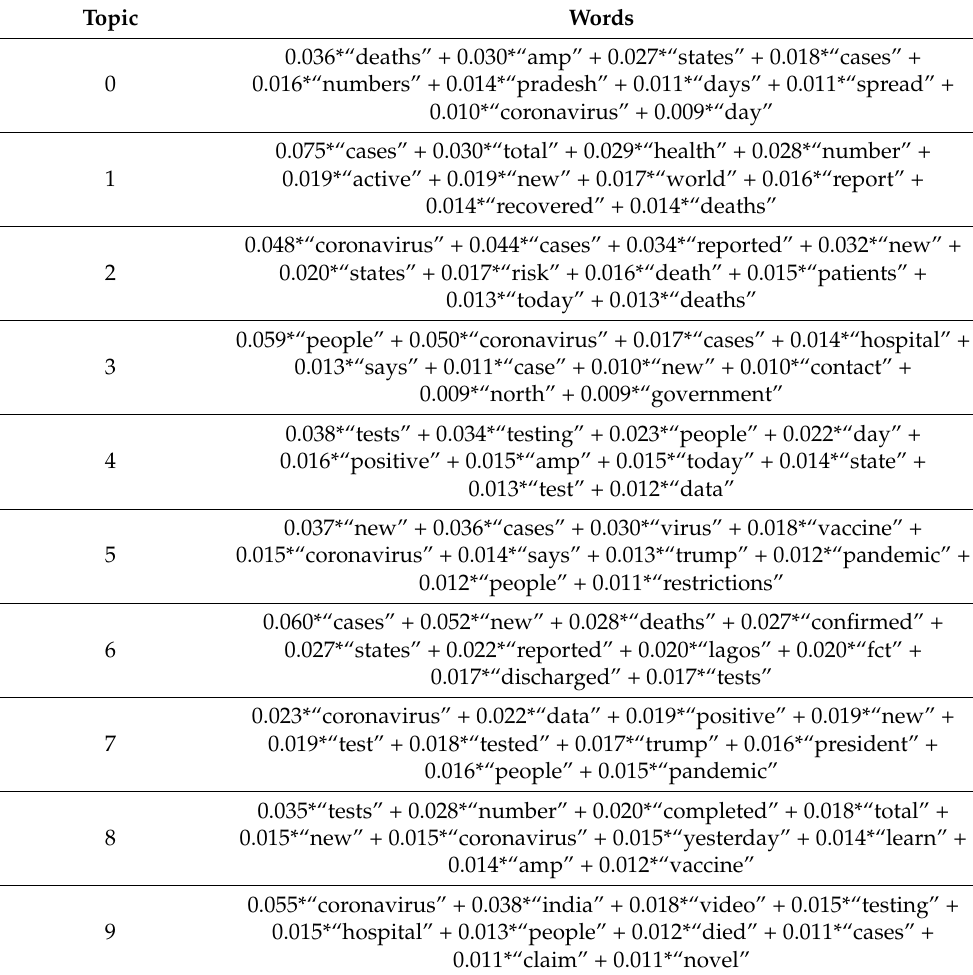
Table 4. Topic Terms and Their Weight (* means “for